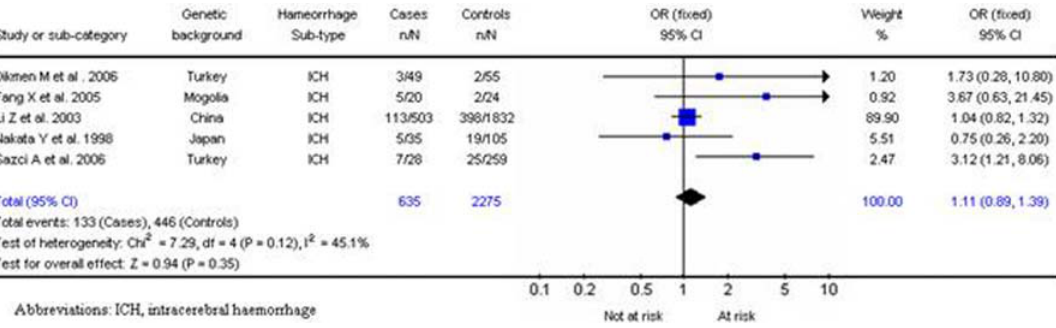
Figure 8. Results for MTHFR/677TT gene and intracerebral haemorrhage.